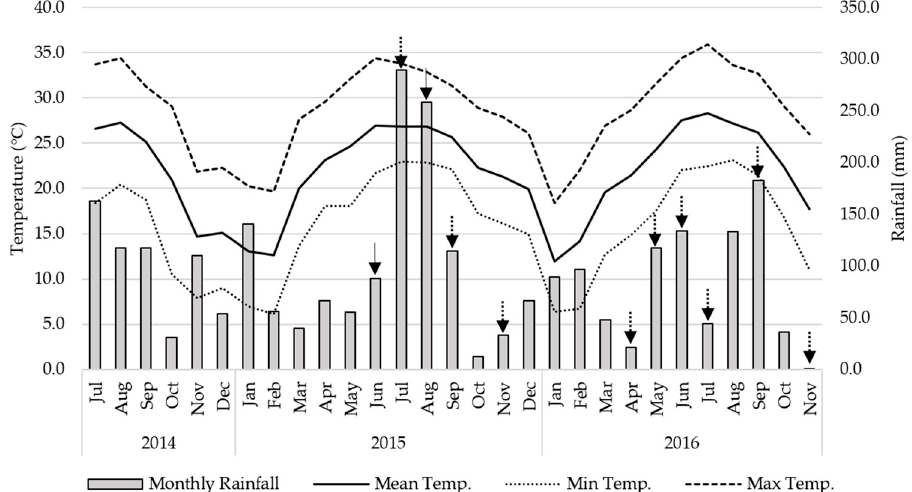
Figure 1. Maximum (Max Temp.), Minimum (Min Temp.), and Mean (Mean Temp.) monthly temperature (°C) and rainfall (mm) during the experimental period (April 2015 to November 2016). The arrows show the nutritive values sampling dates. The integer line refers to the whole population assessment, whereas the dashed line shows sampling date for the selected population.